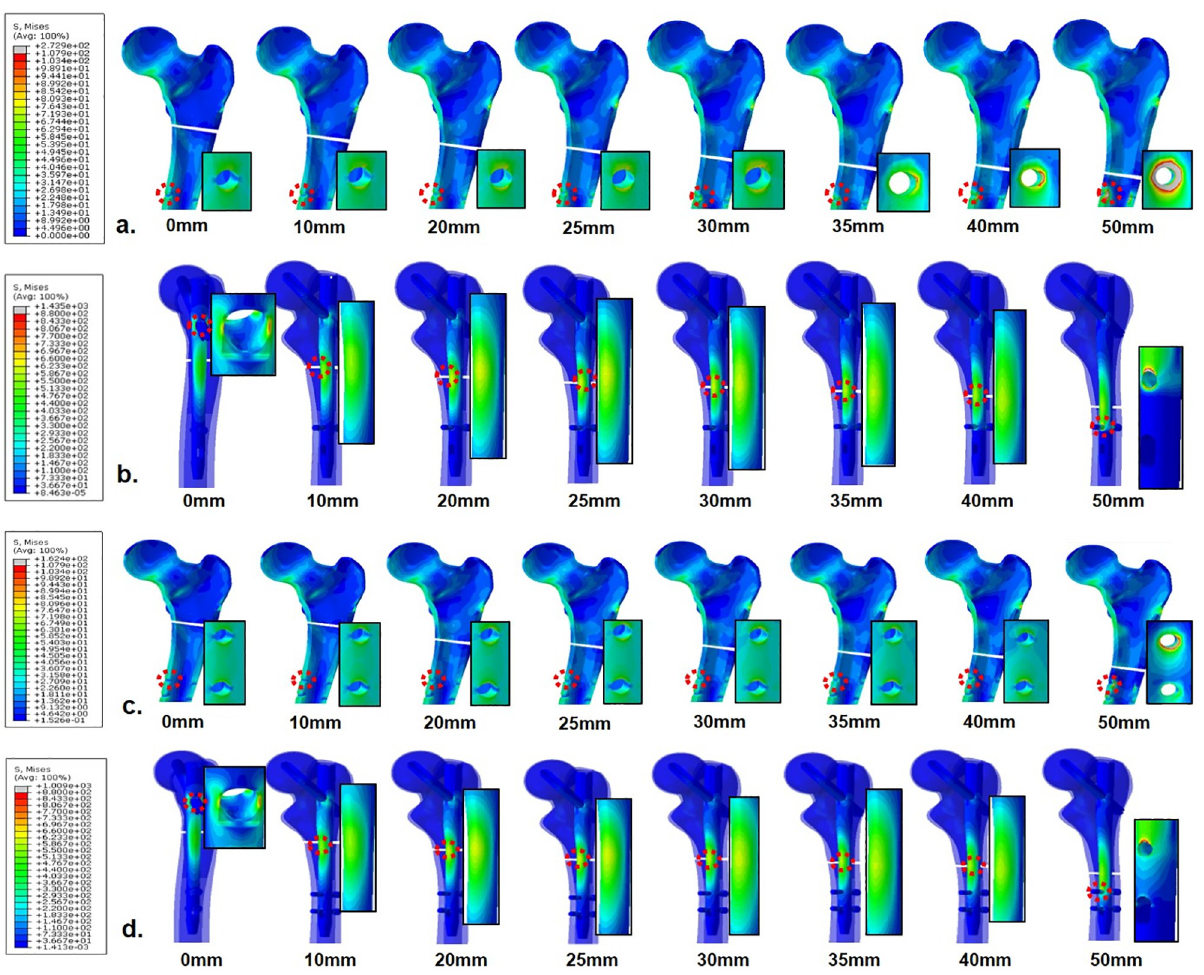
Fig 5. Stress distribution around the cortical bone and implant of finite element models using 1 (a, b) and 2 (c, d) distal screw fixation in 3 mm fracture gap, osteoporotic bone. The enlarged image portion represents the point at which the peak stress was observed.